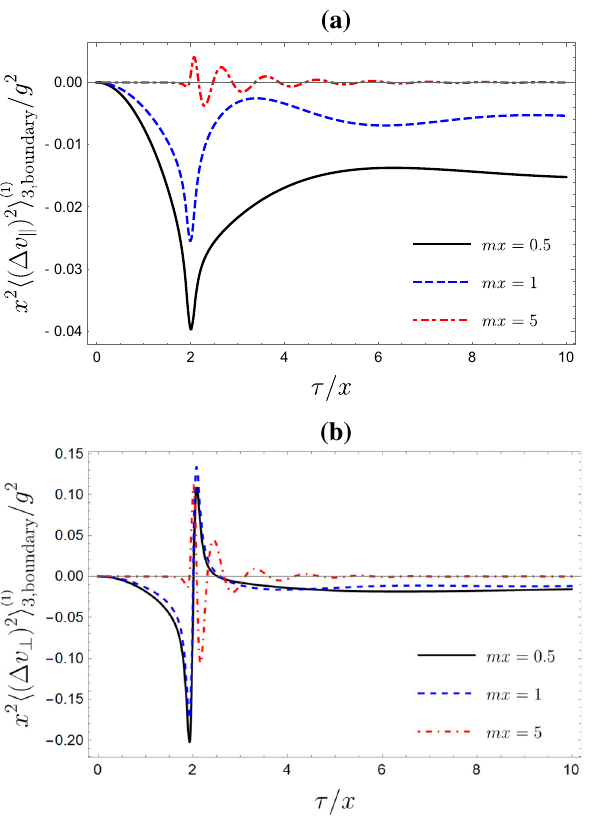
Fig. 6 Late-time behavior of the velocity dispersions for D = 3 as function of the switching time. Here we set mx = 1, and β/ x = 1. a Late-timedispersionsfortheparalleldirections. b Late-timedispersions for the perpendicular direction. The boundary contribution is negative, opposing the thermal part, so that, for certain values of τ s /β subvacuum effects